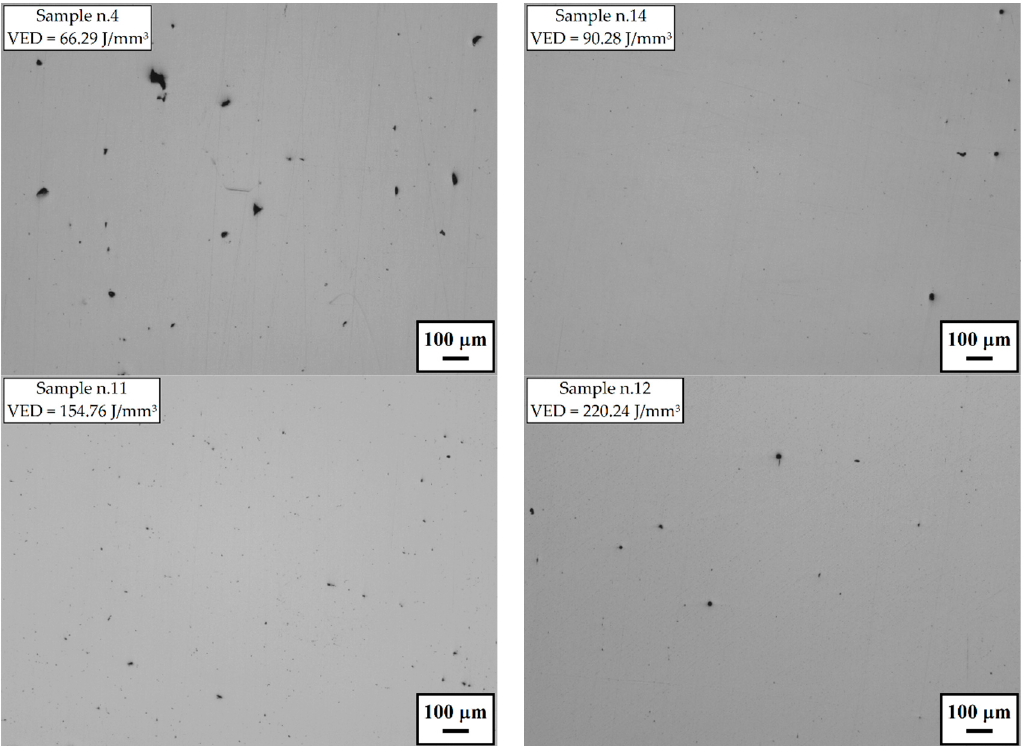
Figure 3. Some example optical micrographs showing the porosity of selective laser melting (SLM) Inconel 718 samples obtained with different volumetric energy density (VED) values. Sample n.14 was obtained with a VED value within the optimum processability window (dotted boxes in the plots of Figure 2).